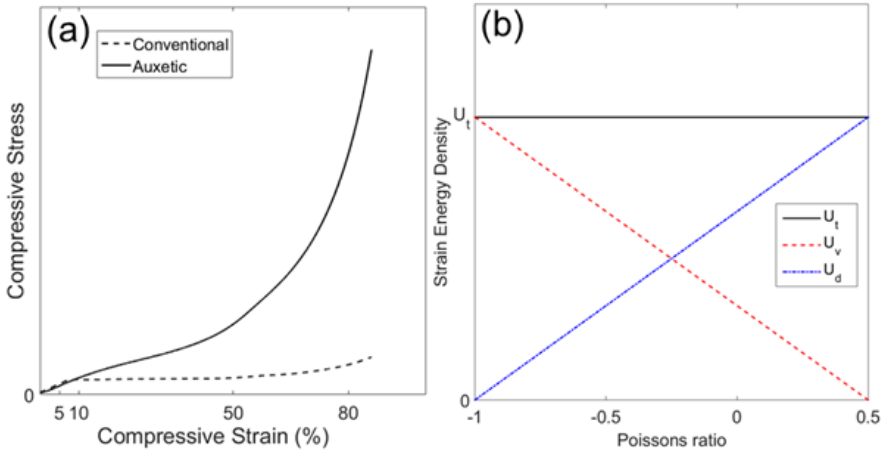
Figure 7. ( a ) Typical compressive stress vs. strain response of auxetic and conventional open cell foam (note cellular collapse between 5 to 10% then hardening beyond 80% strain via densification in open cell foam); ( b ) Strain energy density (Volumetric ( U v , Equation (5)), Distortion ( U d , Equation (6)) & U t , Total) vs. Poisson’s ratio for a linear elastic isotropic material subject to a uniaxial stress. Uniaxial stress and Young’s modulus set to 1 kPa.